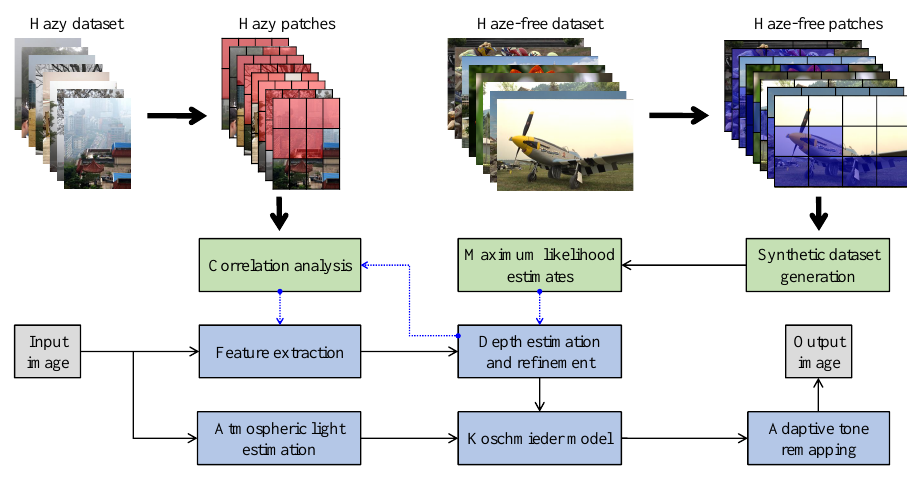
Figure 15. Proposed dehazing framework based on a machine learning